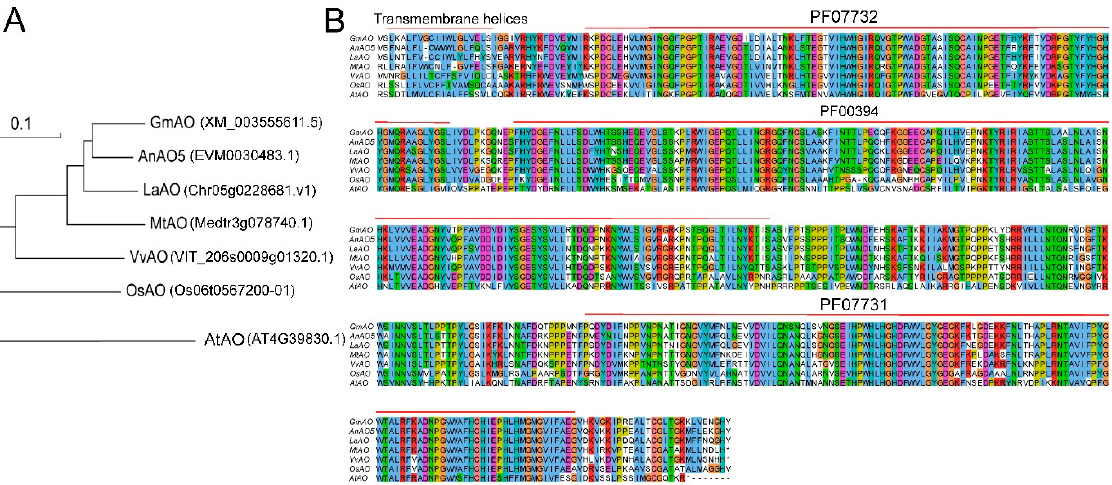
Figure 8. Phylogenetic analyses of AnAO5 and its orthologs. ( A ) The phylogenetic tree of AnAO5 and its orthologs. ( B ) Multiple sequence alignment of AnAO5 and its orthologs.